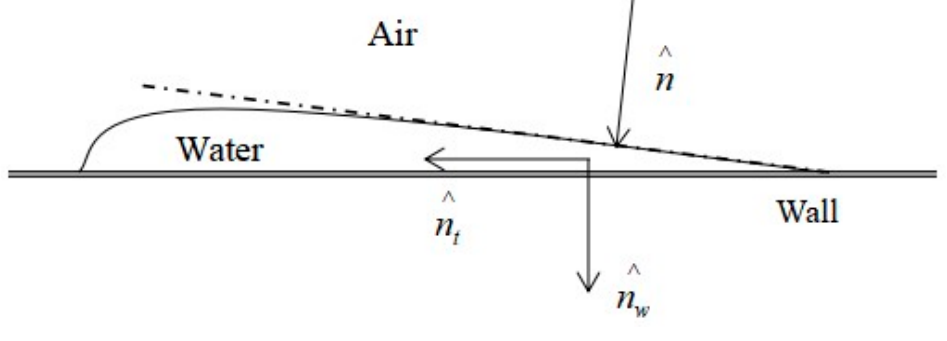
rec represents the static contact angle for the hydrophilic surface. The mathematical